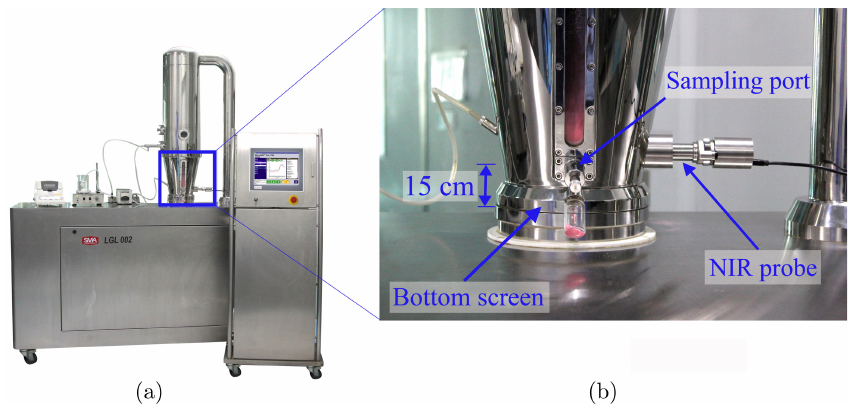
Fig. 1. (a) The system of the °uid bed set-up used for granulating. (b) denotes the position of the NIR probe.